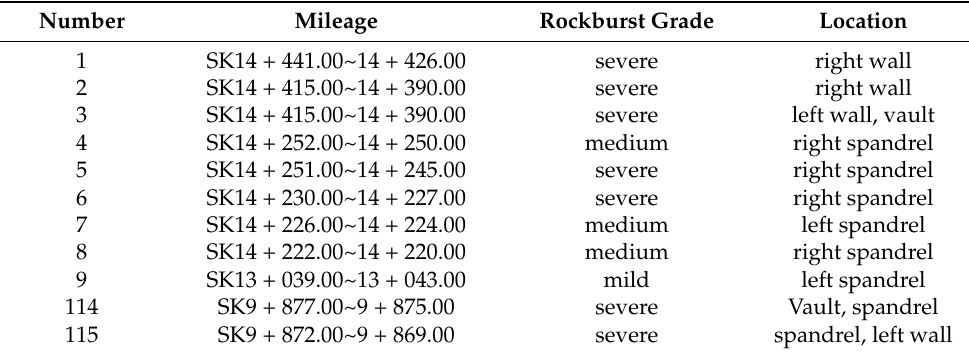
Table 7. Location statistics of rockburst in a construction drainage